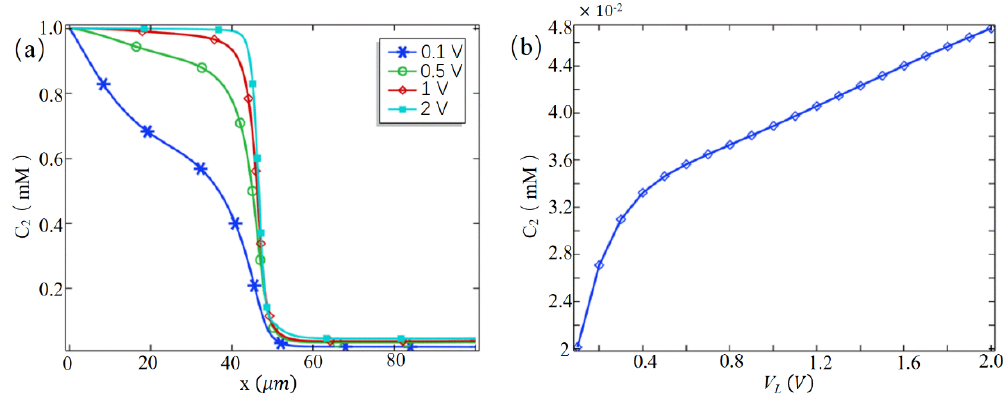
Figure 4. ( a ) The concentration curve of Cl (cid:2879) along the channel symmetry line at different inlet potentials; ( b ) at the outlet, the average concentration of Cl (cid:2879) with the inlet potential.